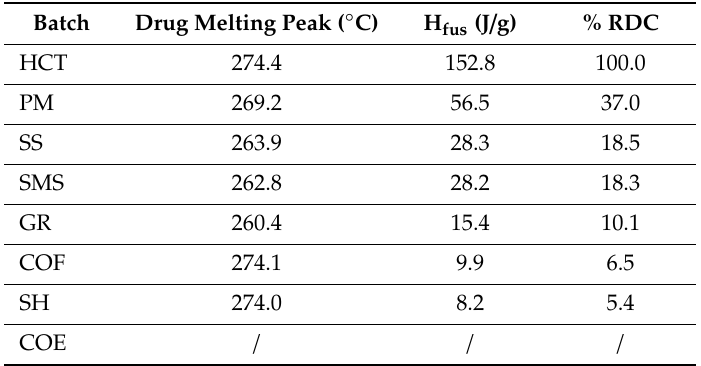
Table 3. Thermal parameters and % residual drug crystallinity (% RDC) of hydrochlorothiazide (HCT) alone or in the di ff erent 1:4 w / w systems with sepiolite prepared by physical mixing (PM), solvent-sonication (SS), solvent magnetic stirring (SMS), co-grinding (GR), co-fusion (COF), solvent-heating (SH), and co-evaporation